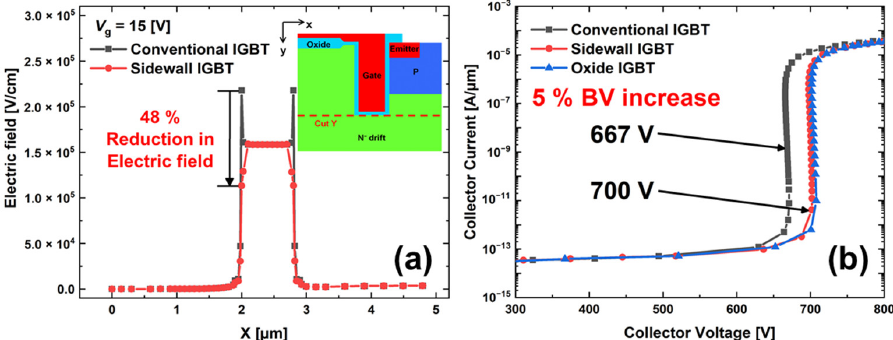
Figure 4. ( a ) Electric field curves distributions of the C-IGBT and S-IGBT on the oxide surface. ( b ) Breakdown voltage characteristic curves of the C-IGBT and S-IGBT. ( b ) Breakdown voltage characteristic curves of the C-IGBT and